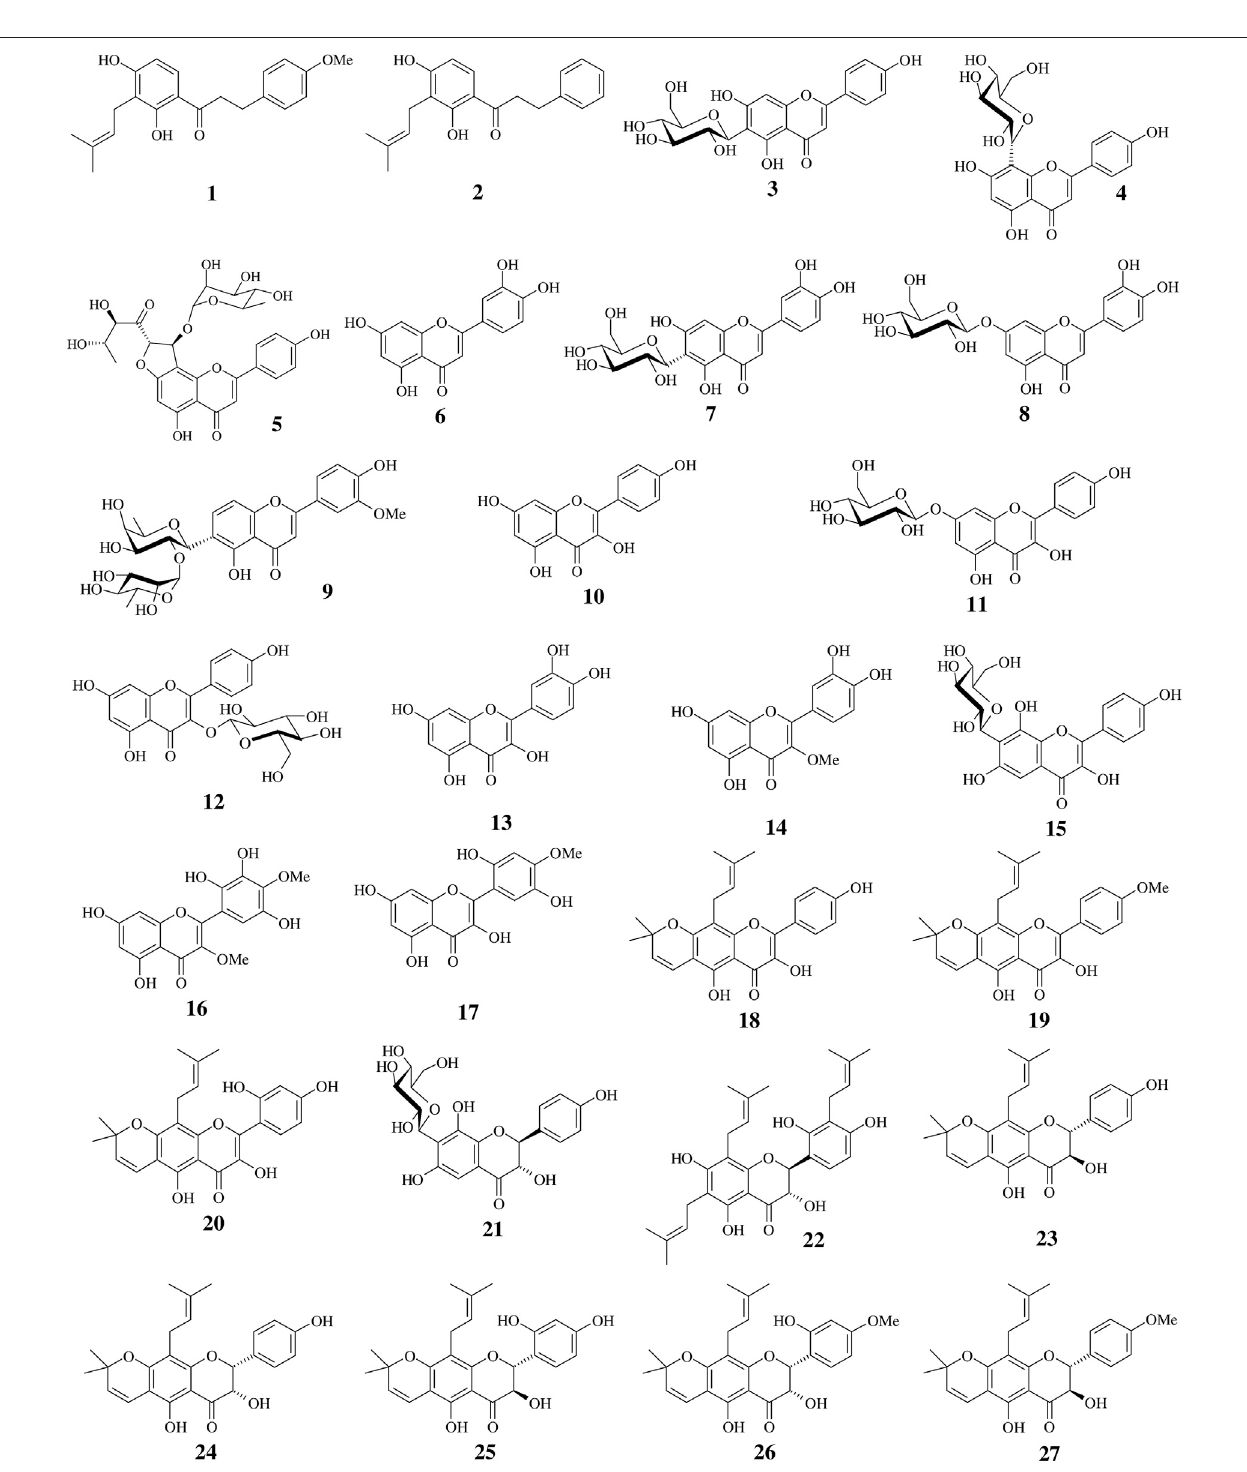
FIGURE 2 | Structures of dihydrochalcones (1 – 2) , fl avones (3 – 9) , fl avonols (10 – 20) , dihydro fl avonols (22 – 33) , fl avanones (34-42) , iso fl avones (43 – 70) , iso fl avanones (71) , coumaronochromones (72 – 74) , chromones (75 – 82) , lignans (83 – 84) , terpenoids (85 – 92) and other compounds (93 – 107) from Eriosema spp.